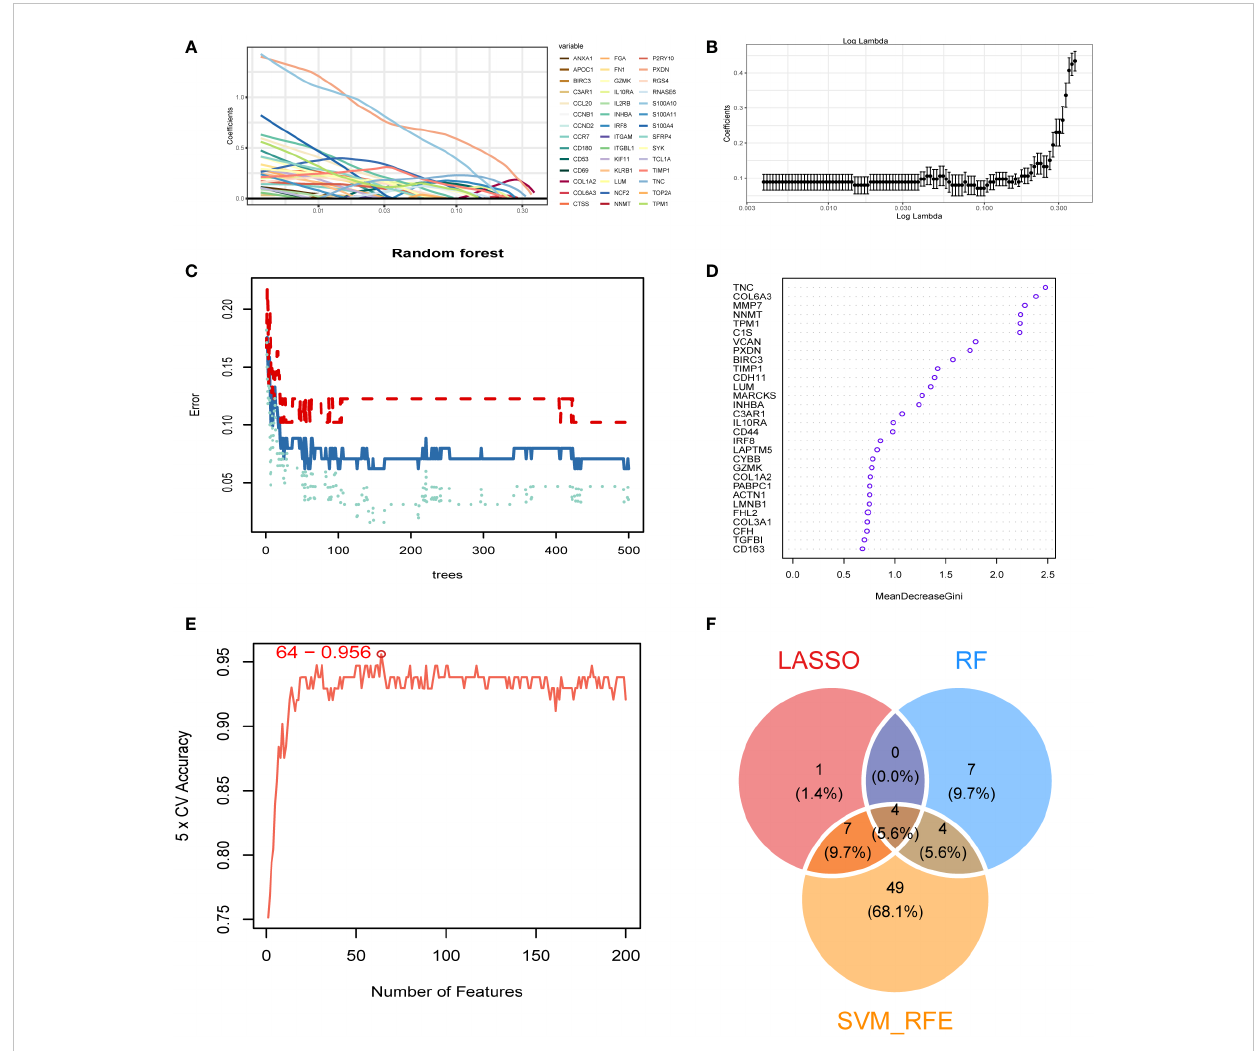
FIGURE 4 Identi fi cation of diagnostic markers. (A, B) A least operator shrinkage and selection operator (LASSO) logistic regression was used to screen characteristic variables. (C) The relationship between the number and the error of random forest. Red, green, and blue represent the error of C1 subtype, C2 subtype and all samples. (D) Ordination plot of gene importance scores. (E) The accuracy curve of characteristic variables for the fi rst 200 genes using the support vector machine – recursive feature eliminator (SVM – RFE) algorithm. The red circle indicates the position with the highest accuracy. (F) Venn diagram showing the intersection feature variables fi ltered by the three